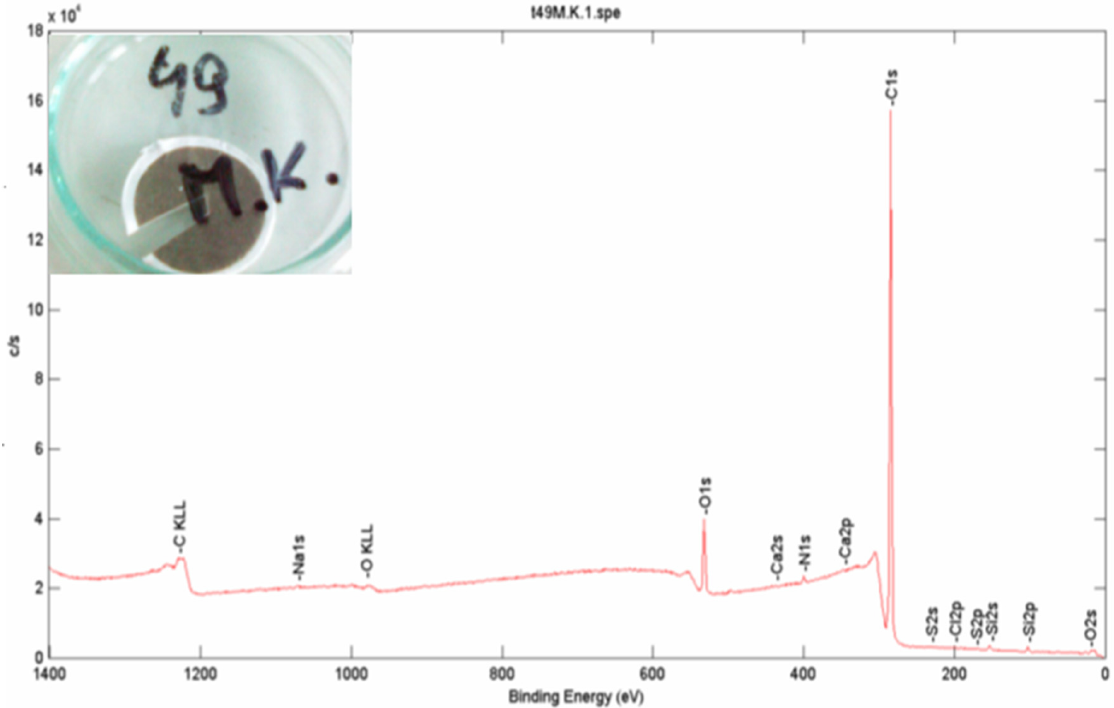
Figure 5. Example of the XPS spectrum in the energy range 0–1400 eV for the PM 4 in the apartment with ETS in Katowice.